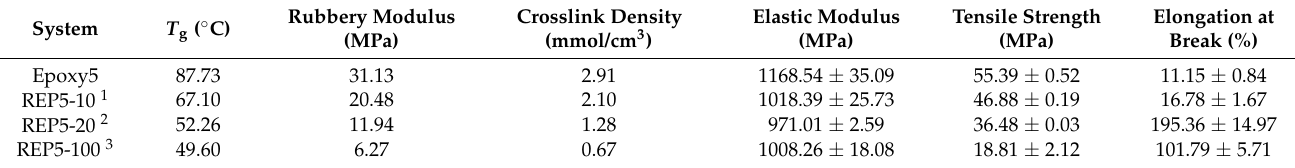
Figure 11. ( a ) The experimental process of the dissolution, recycling, and reuse of Epoxy5: The epoxy samples are immersed in EG (i) and heated at 180 ◦ C for ~20 h to be completely dissolved (ii). The degradation solution is heated at 200 ◦ C in an open environment to obtain the decomposed epoxy oligomer (DEO) (iii). The DEO is poured into the mold (iv) and heated at 180 ◦ C for ~24 h to get a repolymerized sample (v). The DEO is mixed with DGEBA, GA, and DMP-30 (vi) to prepare new epoxy resins (vii). REP5-20 is the epoxy material containing 20 wt% DEO; ( b ) Tan δ curves of epoxy resins containing different amounts of DEO; ( c ) Storage modulus of epoxy resins with different DEO contents; ( d ) Tensile stress-strain curves of epoxy resins with different DEO contents; ( e ) FTIR spectra of fresh Epoxy5 and repolymerized sample. Table 5. Effect of the DEO content on properties of reprocessed epoxy